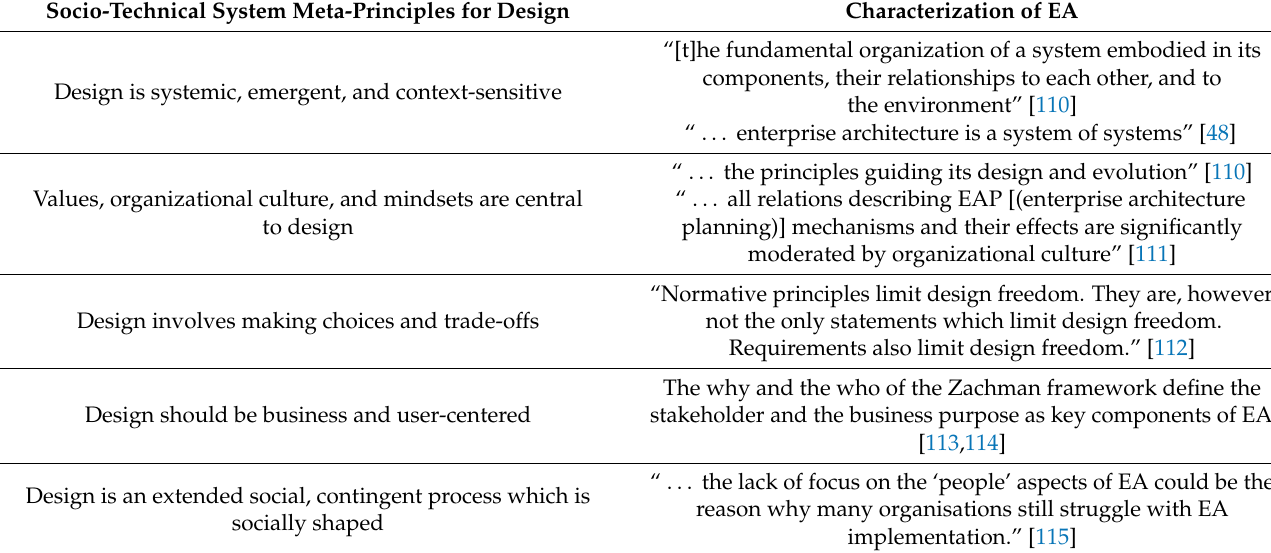
Table 2. EA as socio-technical